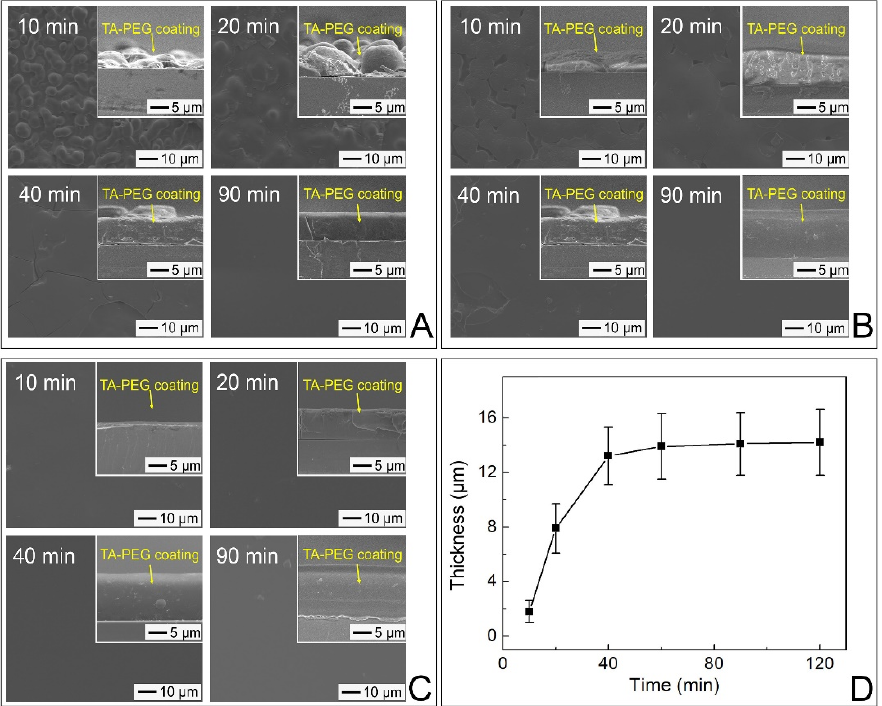
Figure 2. ( A ) 5 mg/mL of TA, 1 mg/mL of PEG with M W = 100 kDa, and 1 M NaCl; ( B ) 5 mg/mL of TA, 2.5 mg/mL of PEG with M W = 100 kDa, and 1 M NaCl; ( C ) 5 mg/mL of TA, 2.5 mg/mL of PEG with M W = 100 kDa, and 2 M NaCl for different periods (10 min, 20 min, 40 min, and 90 min). The cross-sectional SEM images are shown in the insets. ( D ) Changes in thickness of the coating layers on the surface of PMMA substrates incubated with the TA–PEG emulsion containing 5 mg/mL of TA, 2.5 mg/mL of PEG of 100 kDa, and 2 M NaCl.